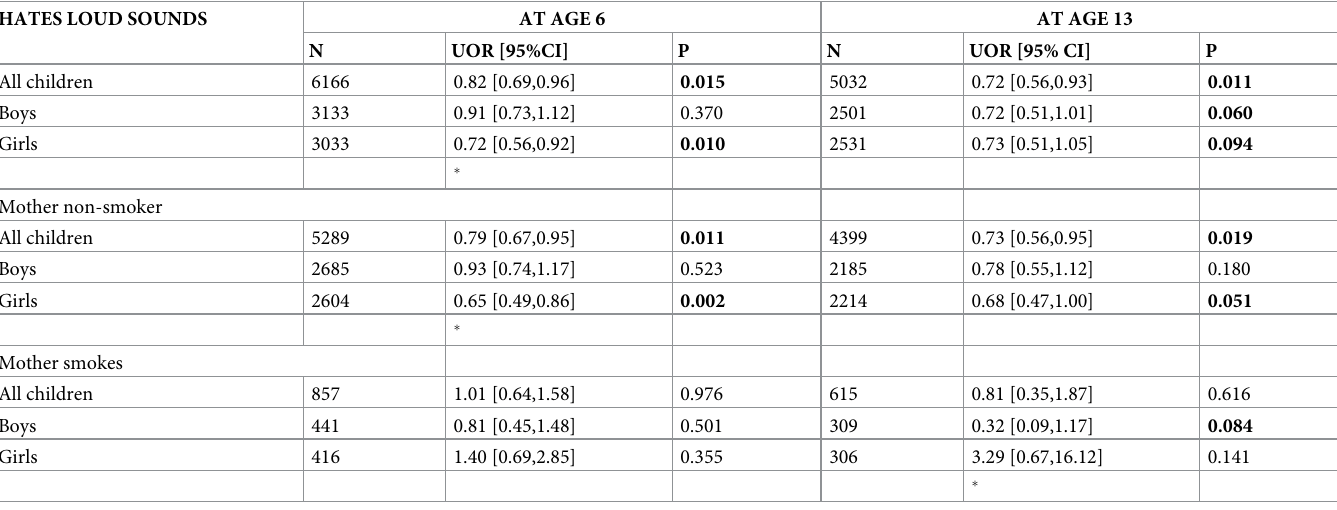
Table 4. Unadjusted risk of the child hating loud sounds at ages 6 and 13 if the paternal grandmother had smoked in pregnancy. [P values < 0.10 are in bold]. HATES LOUD SOUNDS AT AGE 6 AT AGE